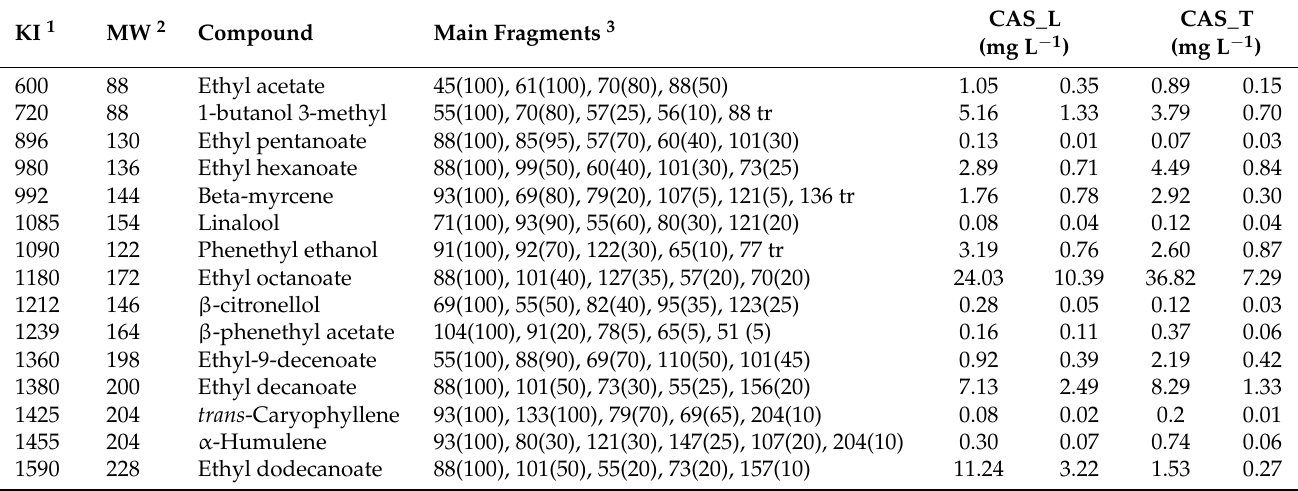
Table 6. Compounds identified by GC-MS and quantified by FID in CAS_T and CAS_L beers SPME headspace. KI 1 MW